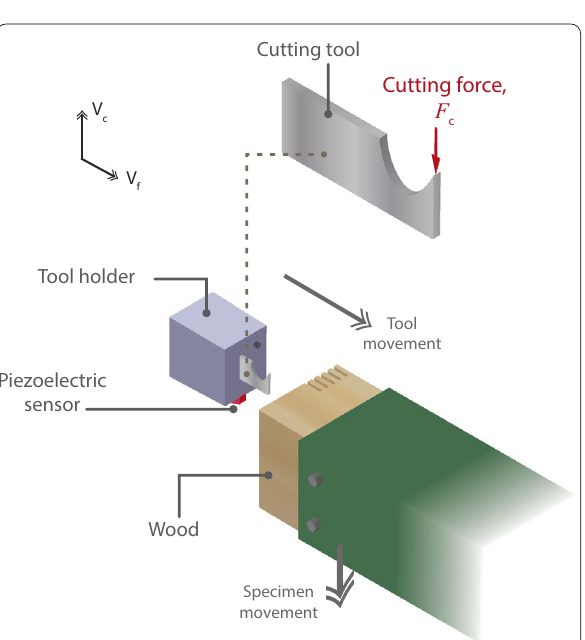
Fig. 6 The experimental setup shows how the wood piece moves while the tooth is moved into the wood by the tooth